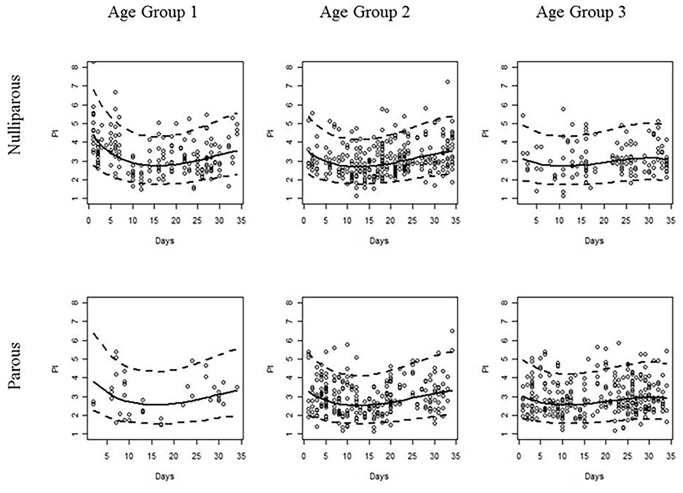
Observed (points) and estimated 5th, 50th, and 95th percentile regression curves of the pulsatility index during the menstrual cycle for each combination of age and parity groups.Nulliparous and parous women are presented in the first and second rows, respectively. The age group increases from the left to right columns.